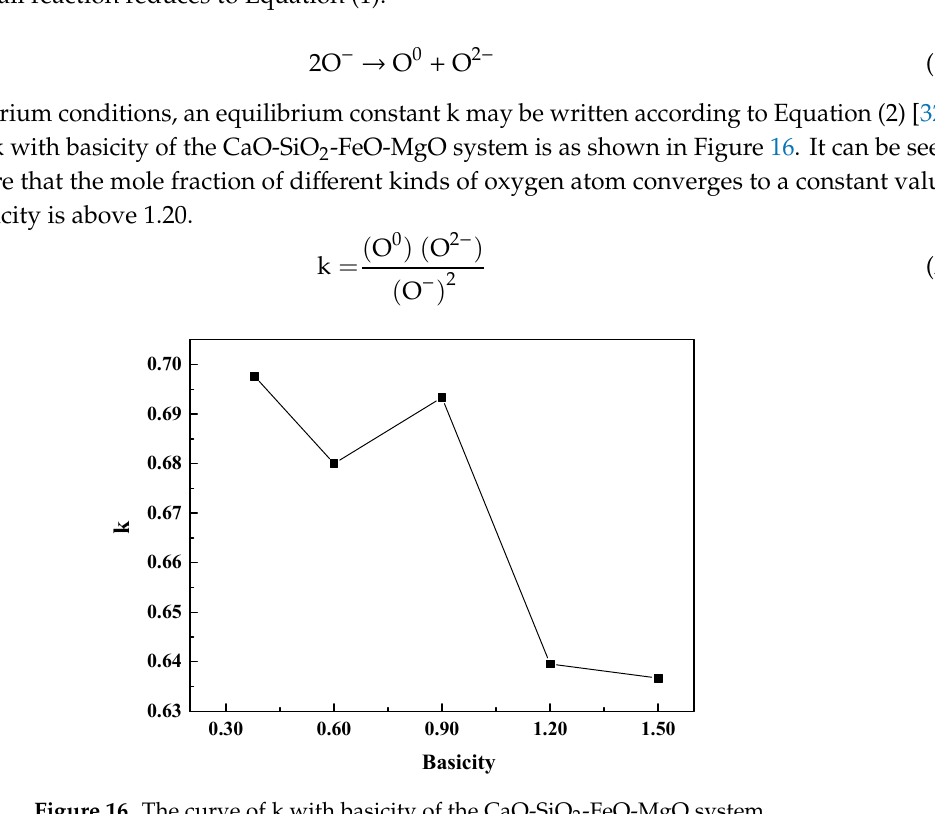
Figure 16. The curve of k with basicity of the CaO-SiO 2 -FeO-MgO system.